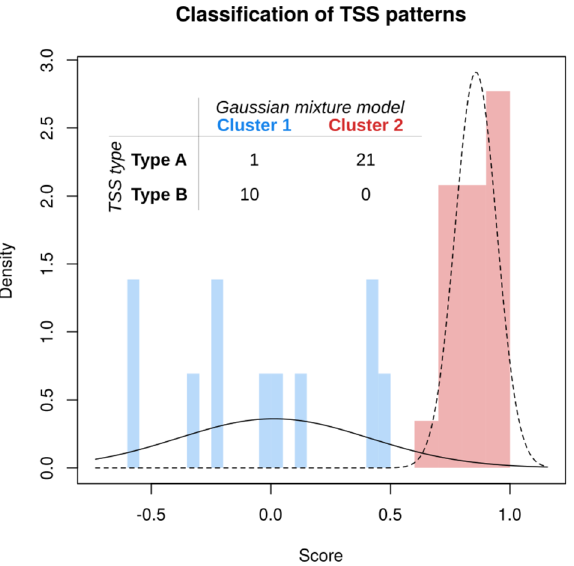
Figure 3. Classification of TSS patterns by Gaussian mixture models. The score was defined as the average difference between the expression levels of the early and late promoters, and a Gaussian mixture model was fitted to these scores. The model with the highest likelihood was univariate, with two components and unequal variance. The TSS patterns were classified according to the averaged difference in expression between the early and late promoters, defined as (early − late)/(early + late). TSS transcription start site.